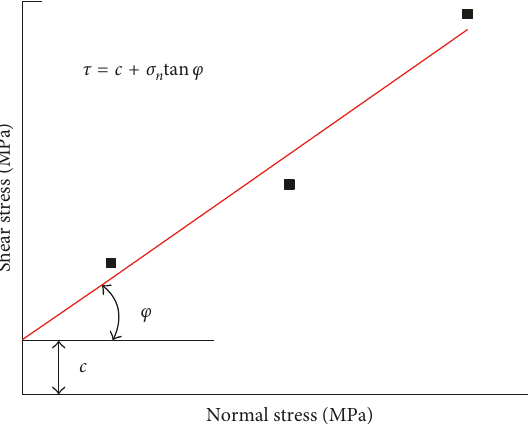
Figure 3: Mohr envelope from oblique shear